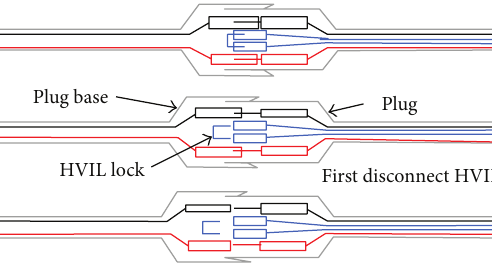
Figure 7: The HVIL model.